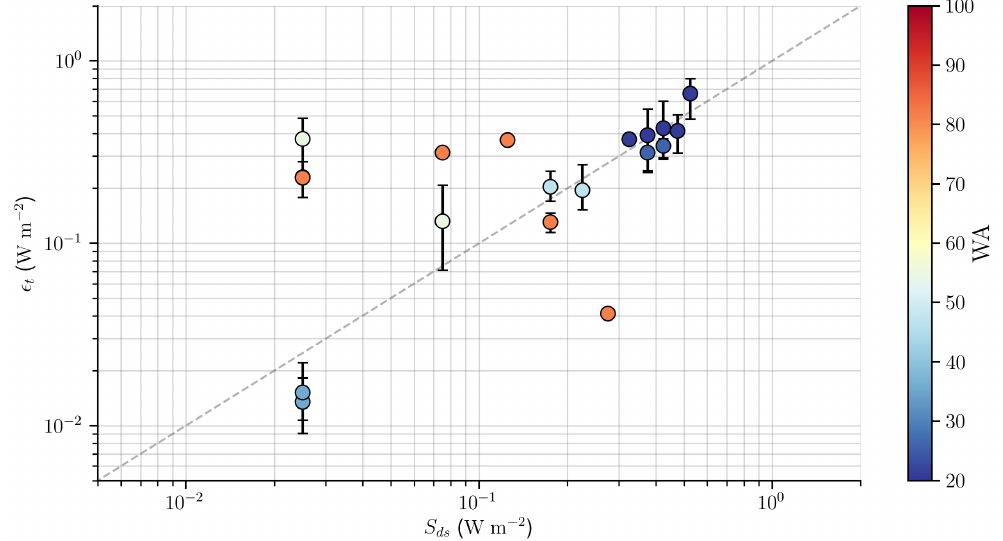
Figure 8. Comparison between total energy dissipation rate derived from SAR images ( (cid:101) t ) and wave dissipation rate calculated by WW3 model ( S ds ). The observed σ wb were grouped into 1 dB bins, where the circles with vertical bars are mean values and percentiles of 5% and 95%. Colors represent the wave age of observations (see Table 1).